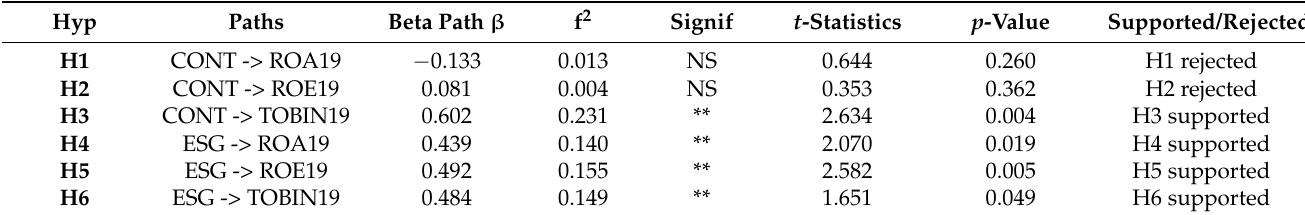
Table 5. Path coefficients, significance and hypotheses